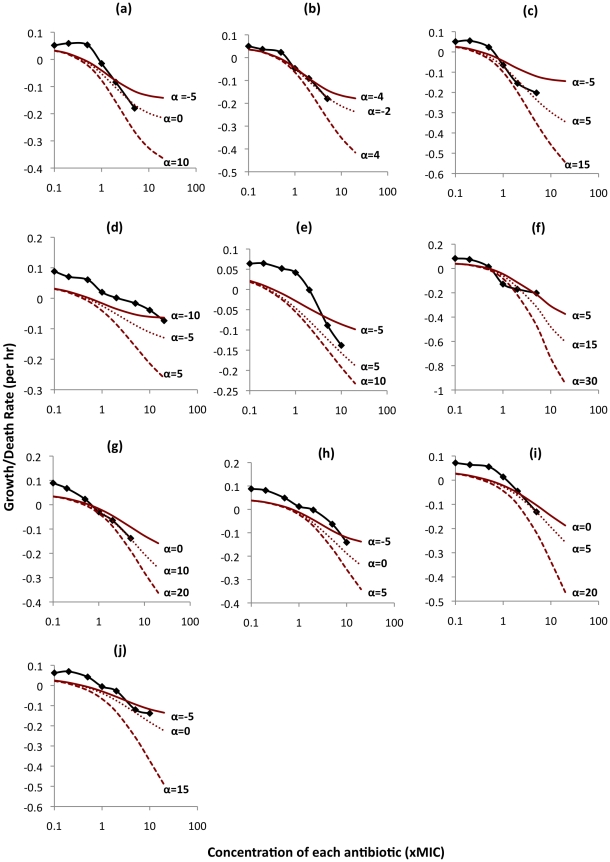
Predicted and observed growth/death rates of M. marinum exposed to different combinations of two antibiotics.Curves without markers represent predicted theoretical rates, and curves with markers represent observed experimental rates. Values of α represent different degrees of interaction between antibiotics. Positive values indicate synergy, negative values antagonism, and values of zero, additivity. (a) amikacin + clarithromycin (b) amikacin + moxifloxacin (c) amikacin + streptomycin (d) clarithromycin + moxifloxacin (e) clarithromycin + streptomycin (f) rifampin + amikacin (g) rifampin + clarithromycin (h) rifampin + moxifloxacin (i) rifampin + streptomycin (j) streptomycin + moxifloxacin.